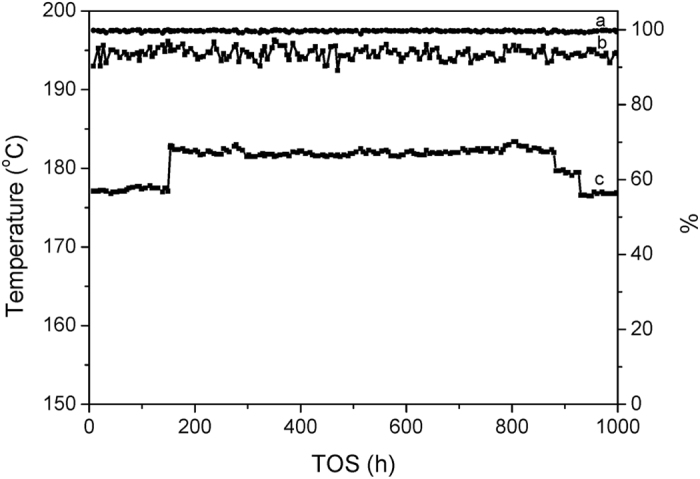
1000 h continuous assessment of the Cu/Al2O3-SiO2 catalyst for EL hydrogenation: (a) EL conversion, %; (b) GVL and 2-MTHF selectivity, %; (c) Temperature, °C.